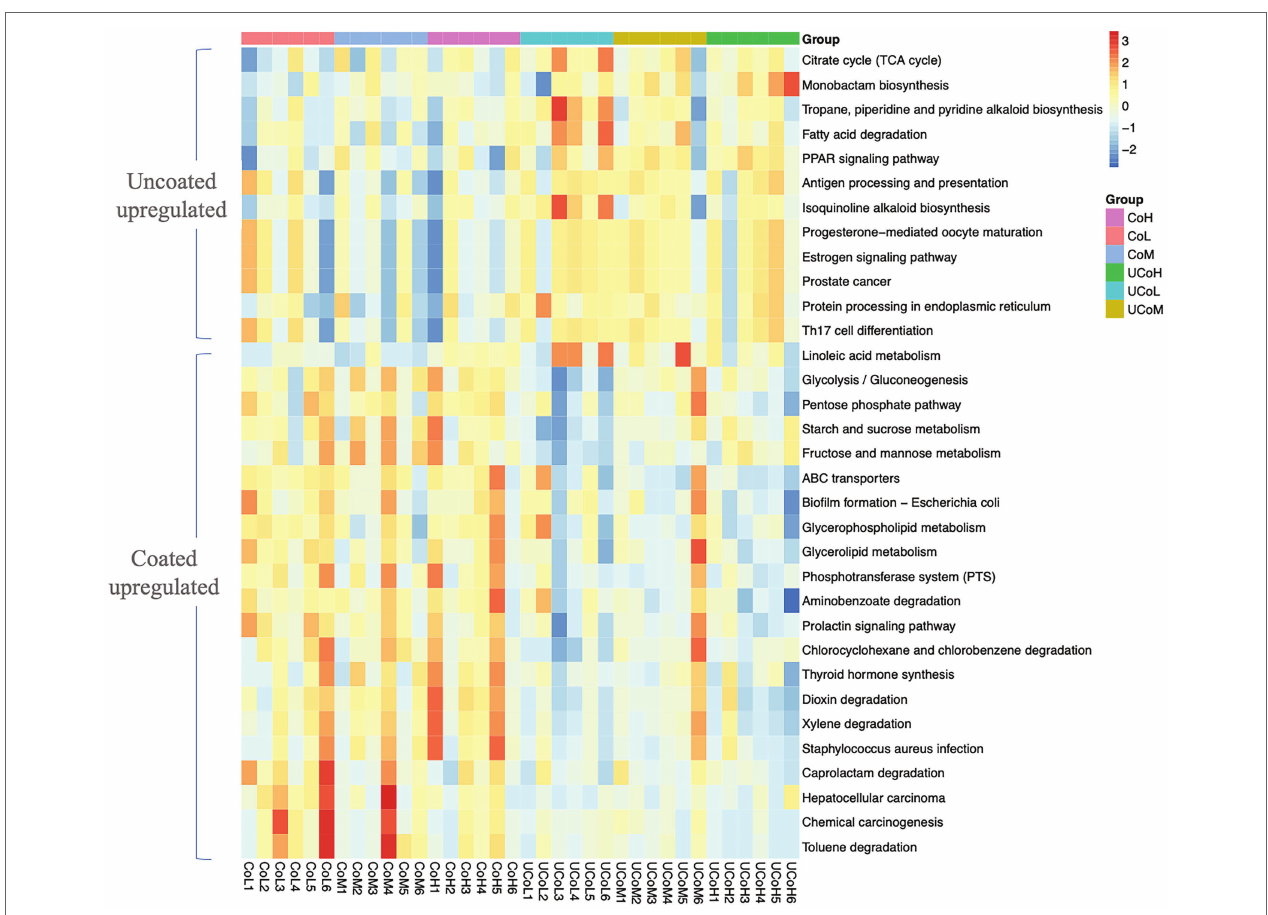
FIGURE 6 | Comparison of microbiota function related to KEGG pathway at level 3. CoL, 300 mg/kg of coated trace mineral treatment; CoM, 500 mg/kg of coated trace mineral treatment; CoH, 1,000 mg/kg of coated trace mineral treatment; UCoL, 300 mg/kg of uncoated trace minerals treatment; UCoM, 500 mg/kg of uncoated trace minerals treatment; and UCoH, 1,000 mg/kg of uncoated trace minerals